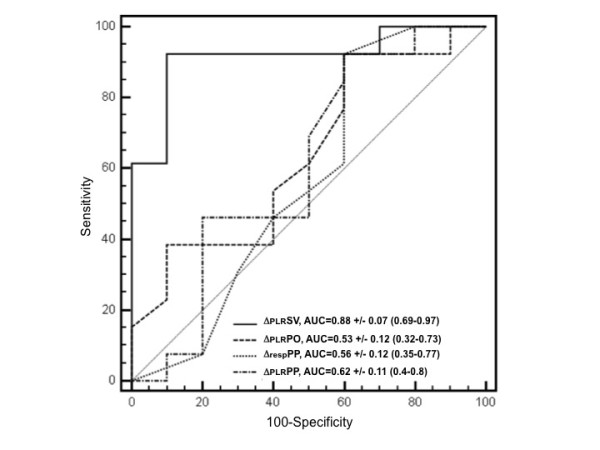
Receiver operating characteristic curves discriminating responders and nonresponders to volume expansion. ΔPLRSV, changes in stroke volume from baseline until after passive leg raising; ΔPLRPO, changes in pump outflow from baseline until after passive leg raising; ΔrespPP, respiratory variation of pulse pressure at baseline; ΔPLRPP, changes in pulse pressure from baseline until after passive leg raising.